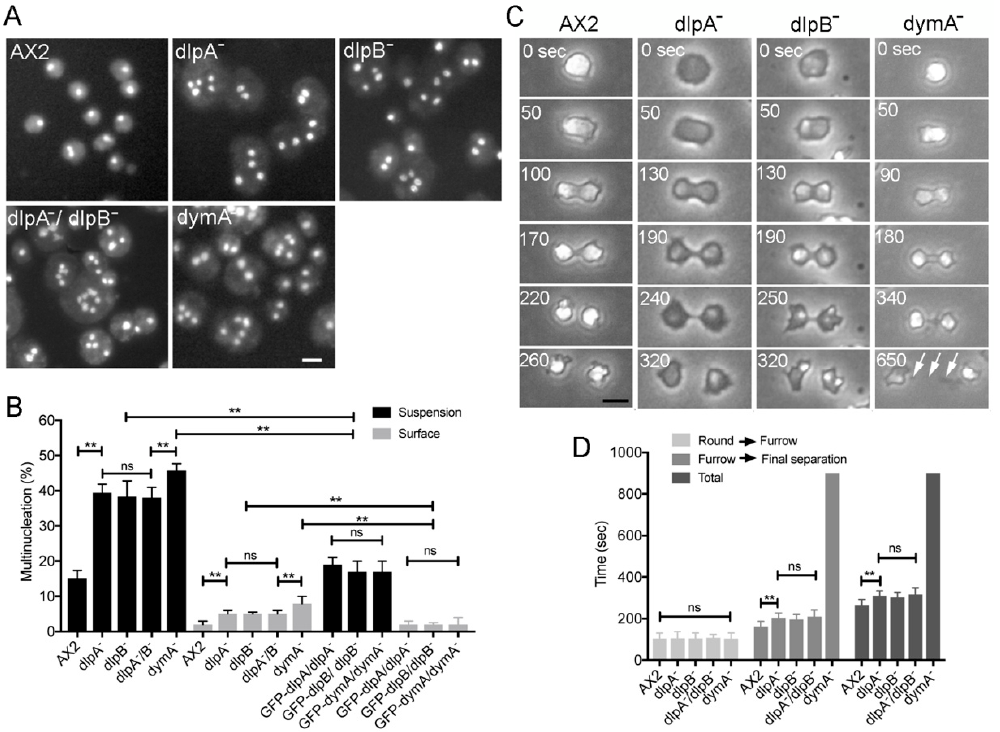
Figure 1. Three kinds of dynamin contribute to cytokinesis. ( A ) Typical fluorescence images of the nuclei of wild-type (AX2) cells and dynamin null mutant cell lines (dlpA - , dlpB - , dlpA - / dlpB - , and dymA - ). Cells were stained with 4,6-diamidino-2-phenylindole (DAPI) after 3 days of culture in suspension. ( B ) Multinucleation of five cell lines and dynamin null cells transformed with the GFP-dynamins cultured on surface and in suspension ( > 500 cells, three independent experiments for each condition). ( C ) Typical phase contrast images of each cell line during cytokinesis on coverslips. DymA - cells showed much longer intercellular bridges (arrows) and took a much longer time to separate. ( D ) The required time from the round stage to the initiation of furrowing, the time from the initiation of furrowing to the final separation, and the total time for the cell division for each cell line ( > 100 cells, three independent experiments for each). The time for dymA - cells was considered as 20 min if it exceeded 20 min. Data are presented as mean ± SD and analyzed by one-way ANOVA with Tukey’s multiple comparison test. ** p ≤ 0.001; ns, not significant, p > 0.05. Bars, 10 µ